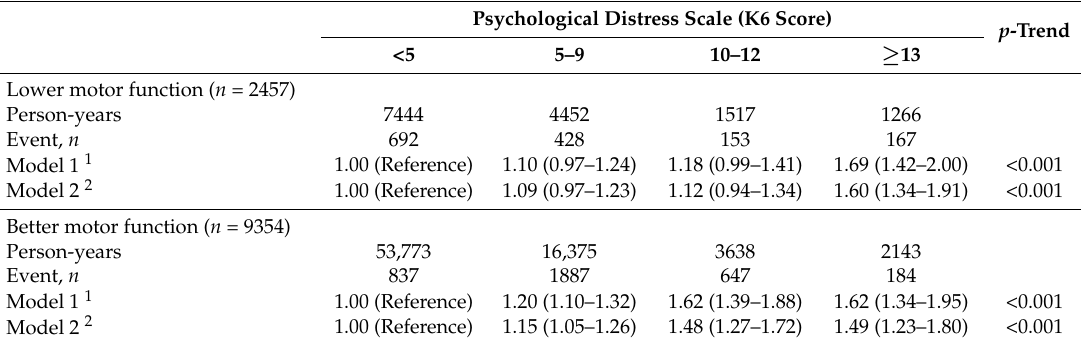
Table 5. Sensitivity analysis: stratified by motor function subgroup.